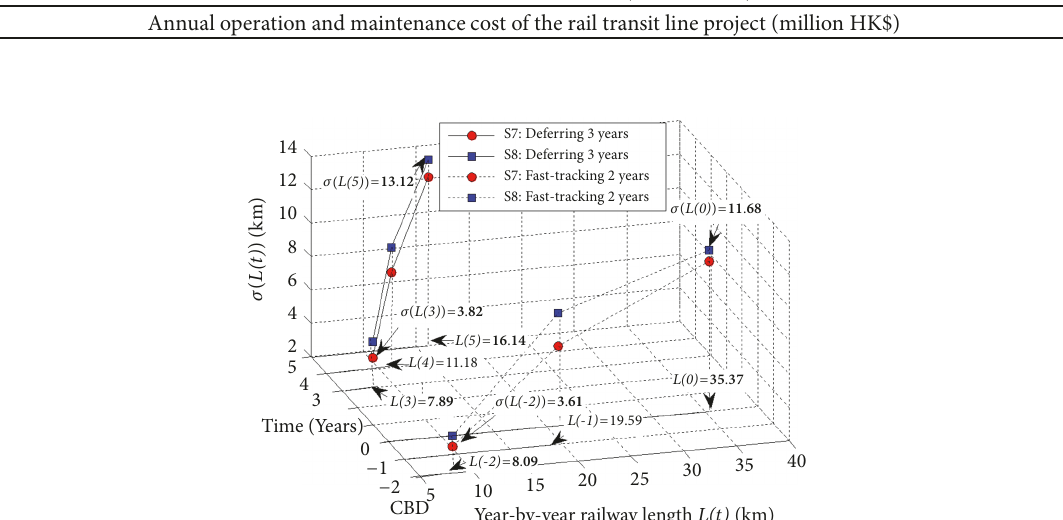
Figure 2: Year-by-year rail length with respect to alternatives of fast-tracking this rail transit line project two years and deferring it three years under Scenarios a and